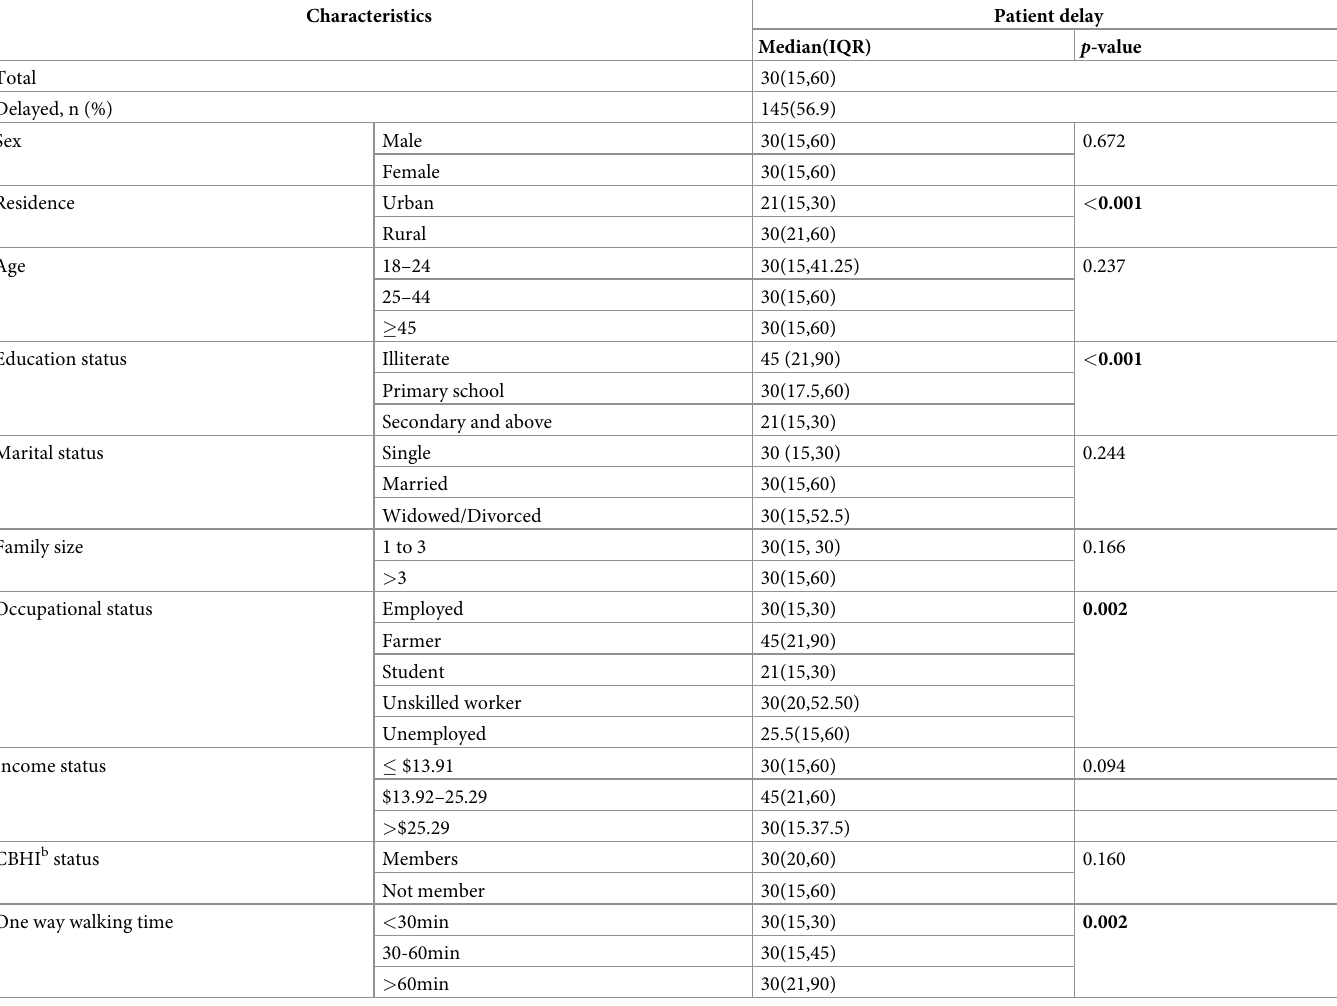
Table 3. Distribution of patient delay by socio-demographic, clinical variables and health-seeking trajectories, non-parametric (Mann–Whitney and Kruskal-Wal- lis) test.